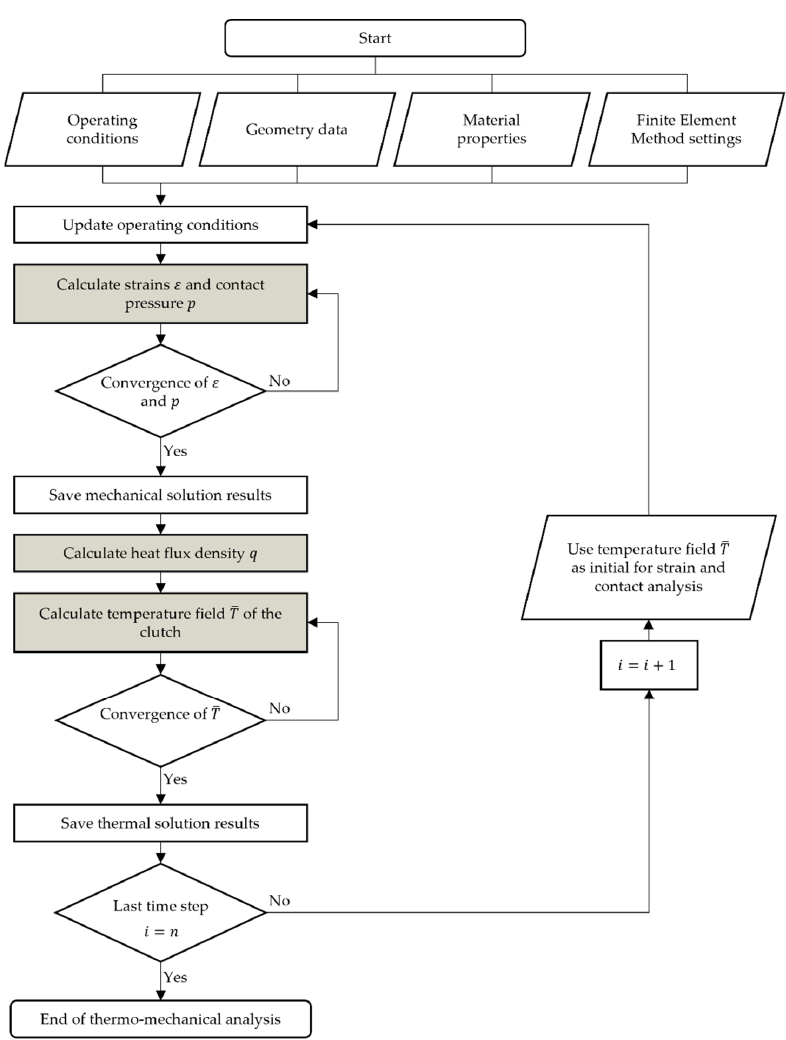
Figure A1. Flow chart for the simulation process [20].